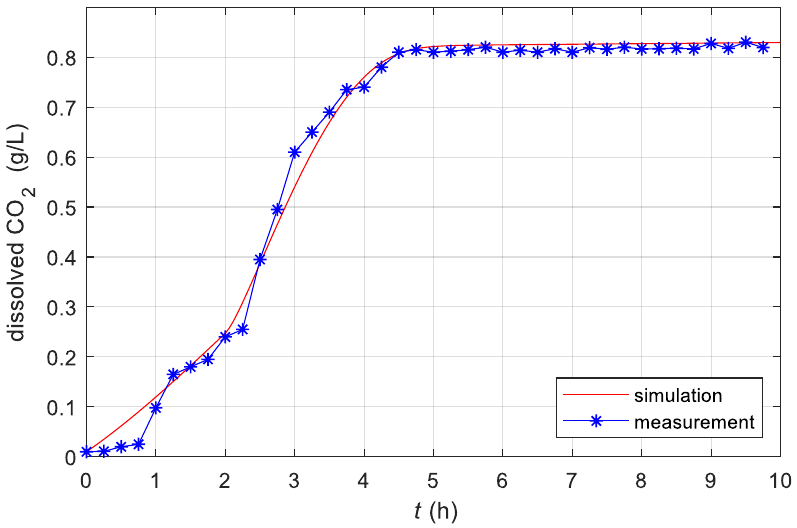
Figure 4. Measured and simulated time courses of dissolved CO 2 concentration during the fermen- tation process with changeable bioreactor temperature (step change of temperature from 22 °C to 29 °C occurred at time t = 2 h).